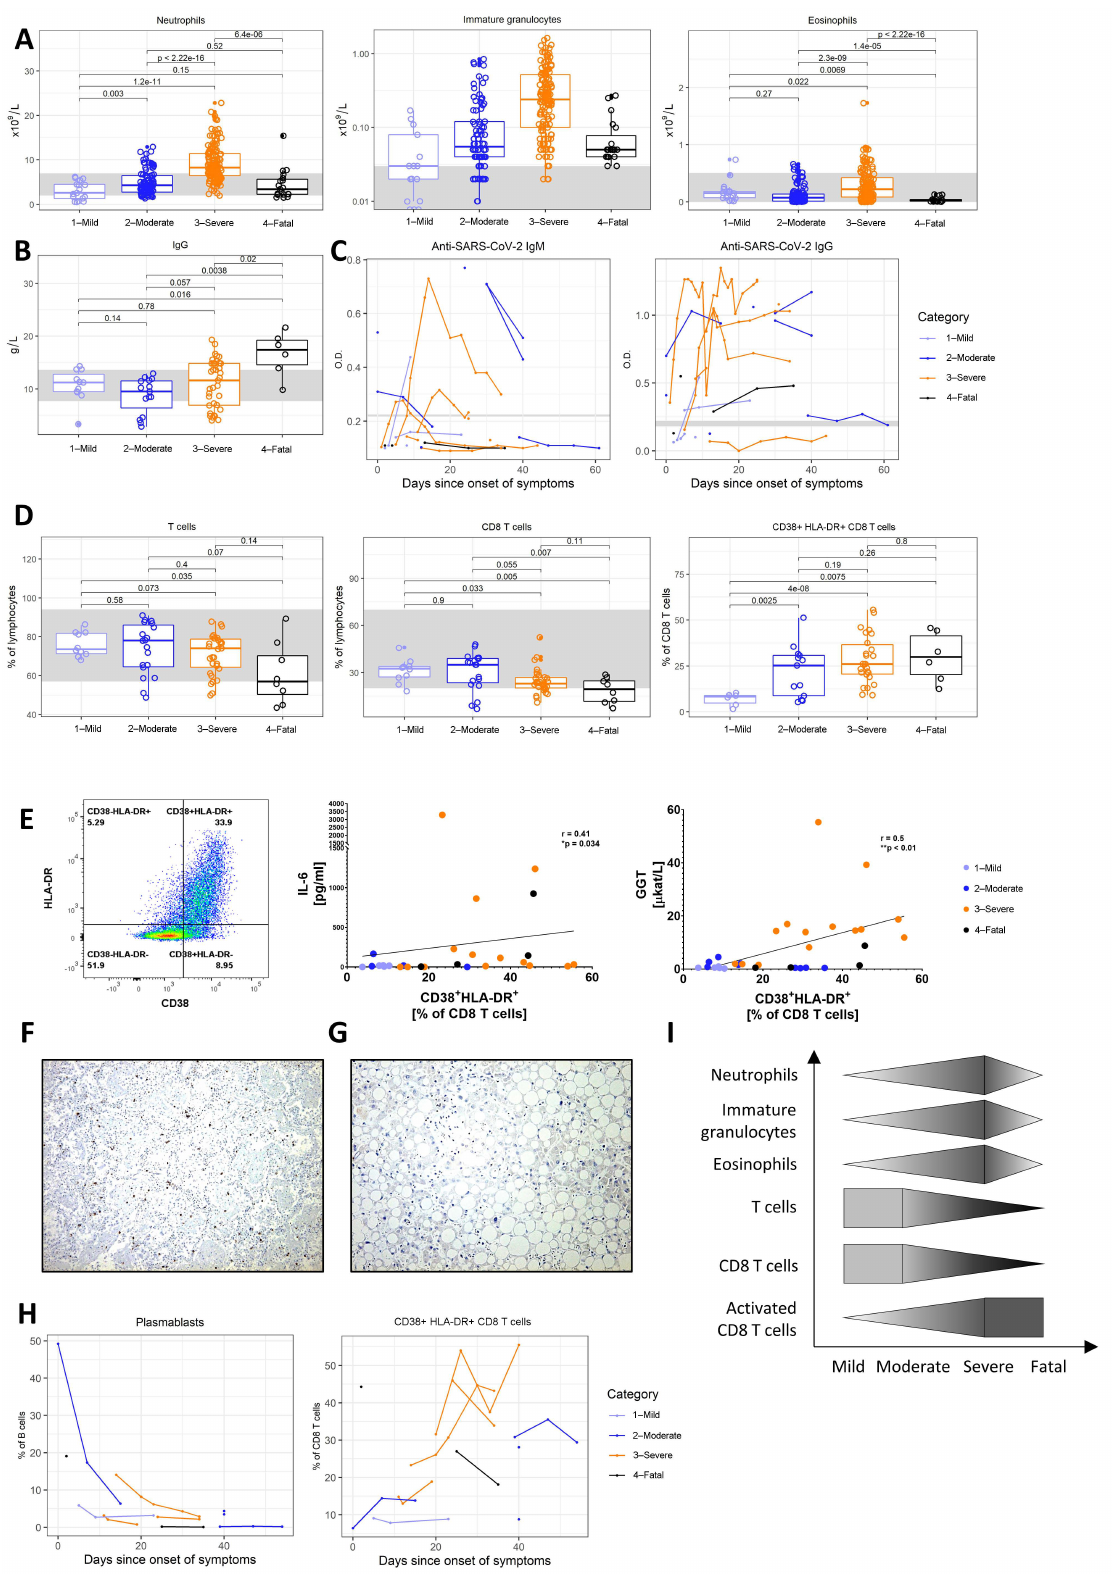
Figure 3. Immunity. ( A ) Neutrophil, immature granulocyte, and eosinophil counts in patients with mild, moderate, severe, and fatal courses of the disease. ( B ) Serum immunoglobulin G (IgG) levels